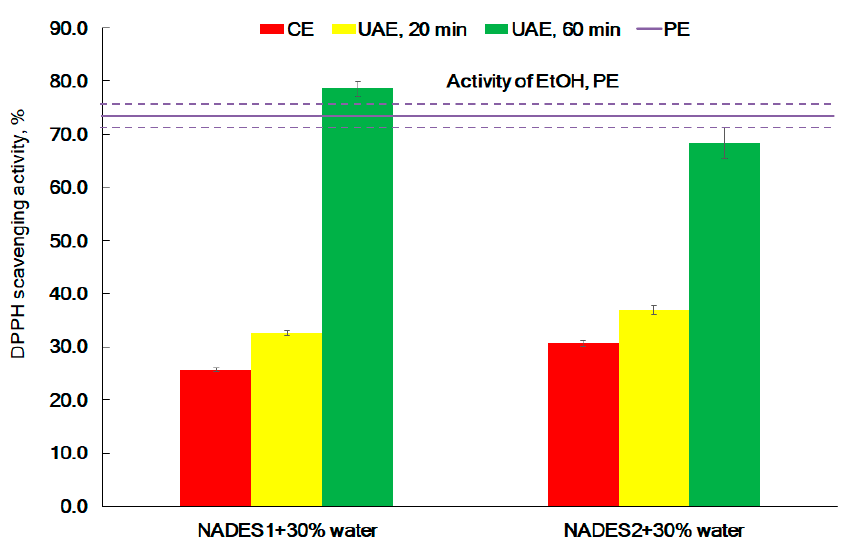
Figure 5. The effect of the extraction method (CE (60 °C), UAE-20 min (25 °C), UAE-60 min (25 °C), and PE (25 °C)) on the antiradical activity of the NADES extracts from F. vesiculosus